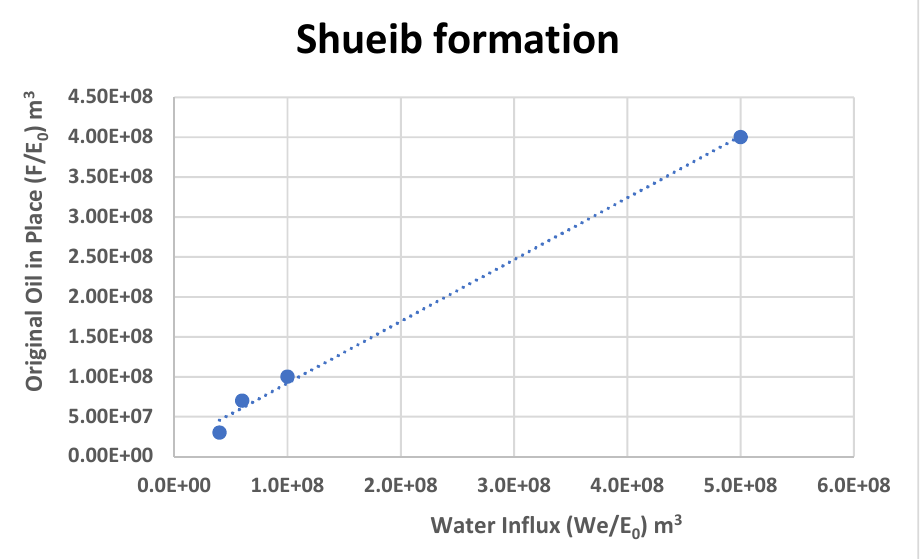
Figure 5. Shueib formation reserve estimations using water influx calculations.